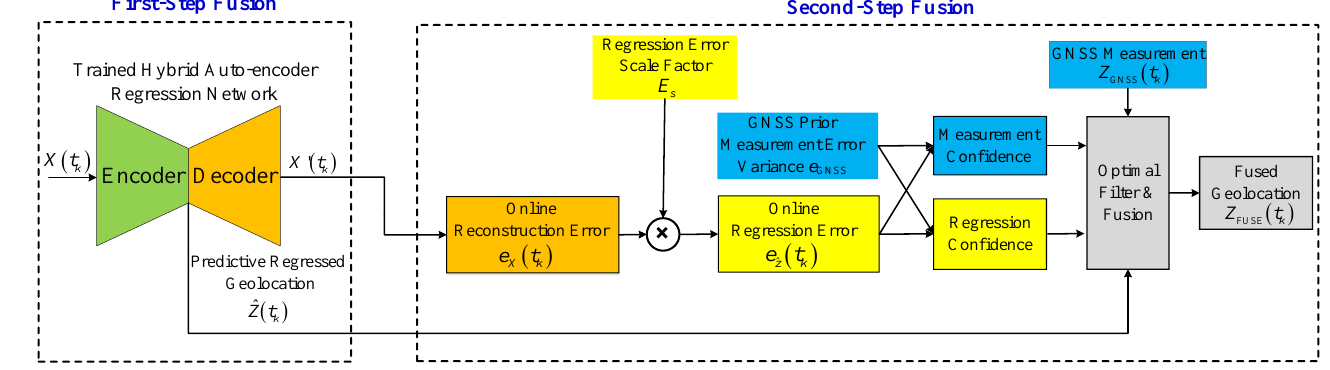
Figure 4. Framework of Stage Two.